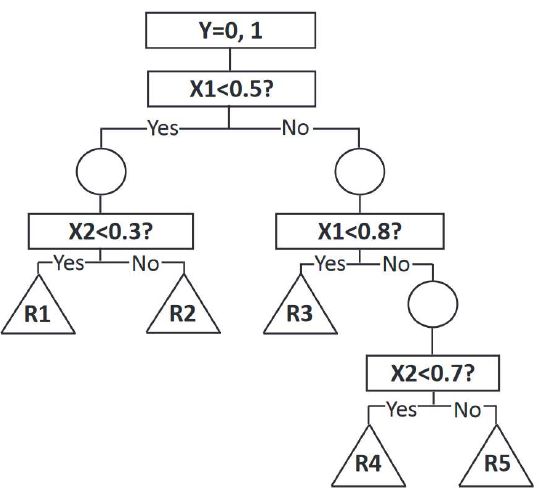
Figure 1. An example of a decision tree that is based on binary target variable Y (adapted from [32]).